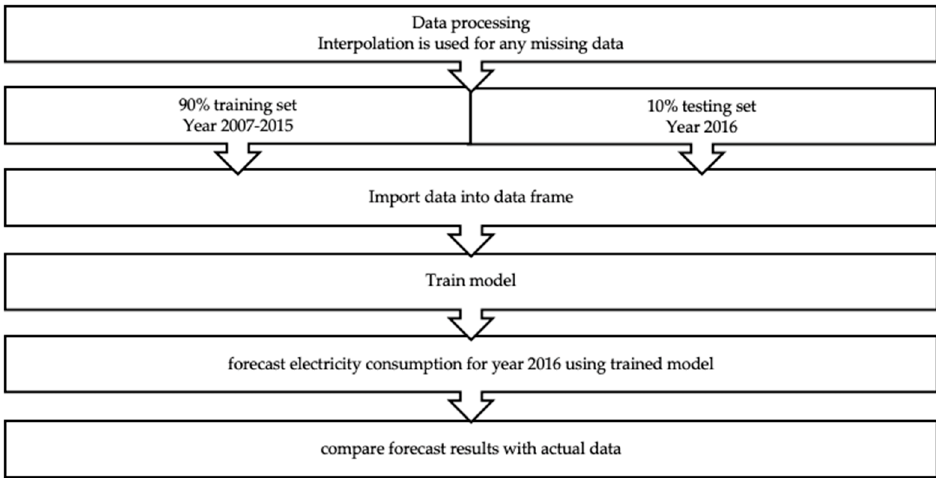
Figure 4. Overview of the forecasting process.